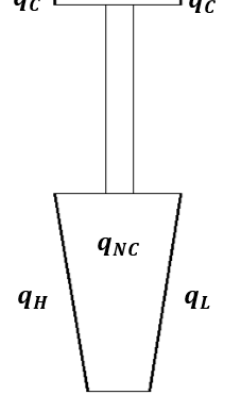
Figure 3. Fundamental sector: different sets of dofs.